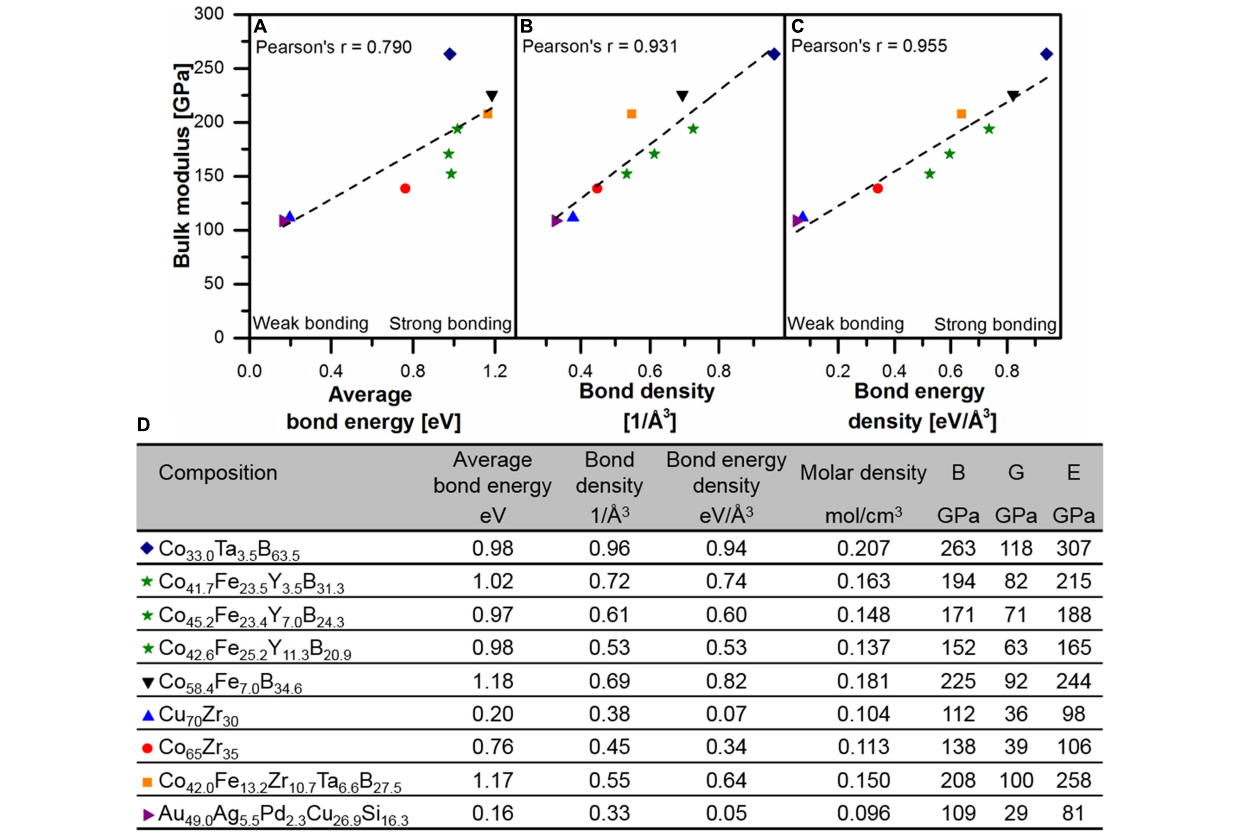
Frontiers in Materials |